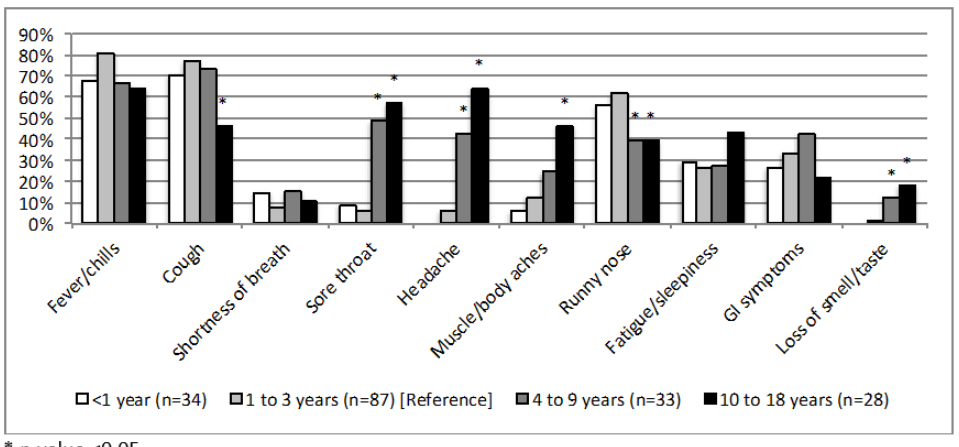
Figure 3. Reported symptoms among children with suspected or diagnosed COVID-19 in NYU CHES, 20 April–31 August 2020 ( n = 182).